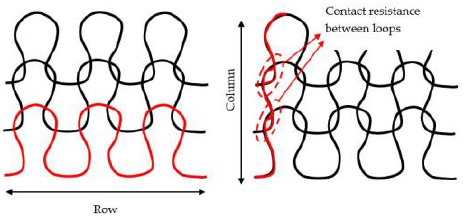
Figure 4. Current path through rows and columns.